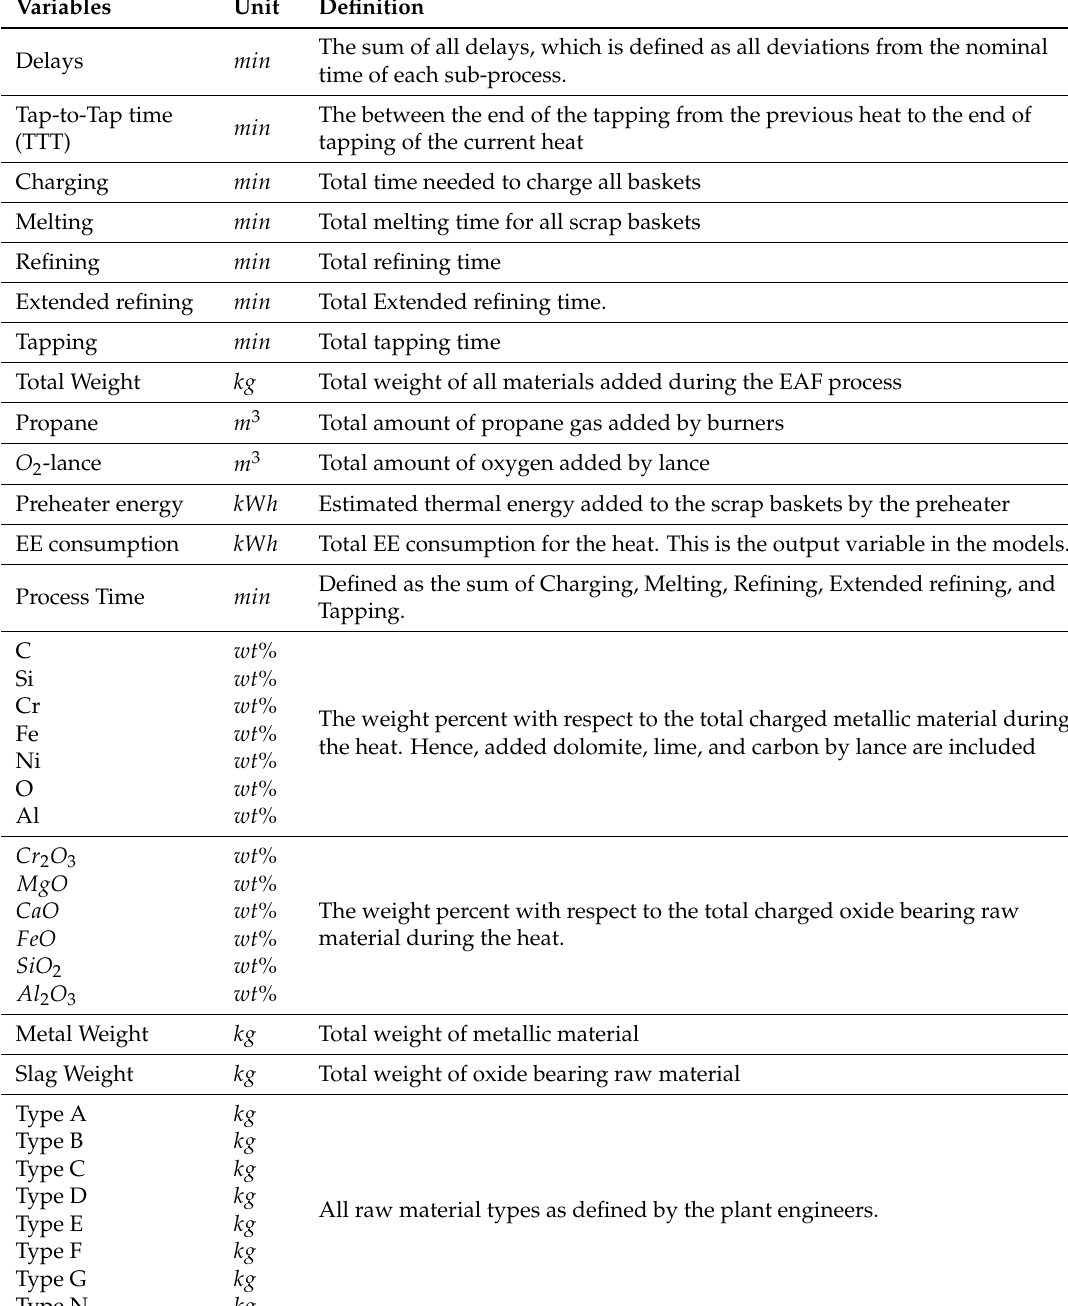
Table 3. The variables used in the